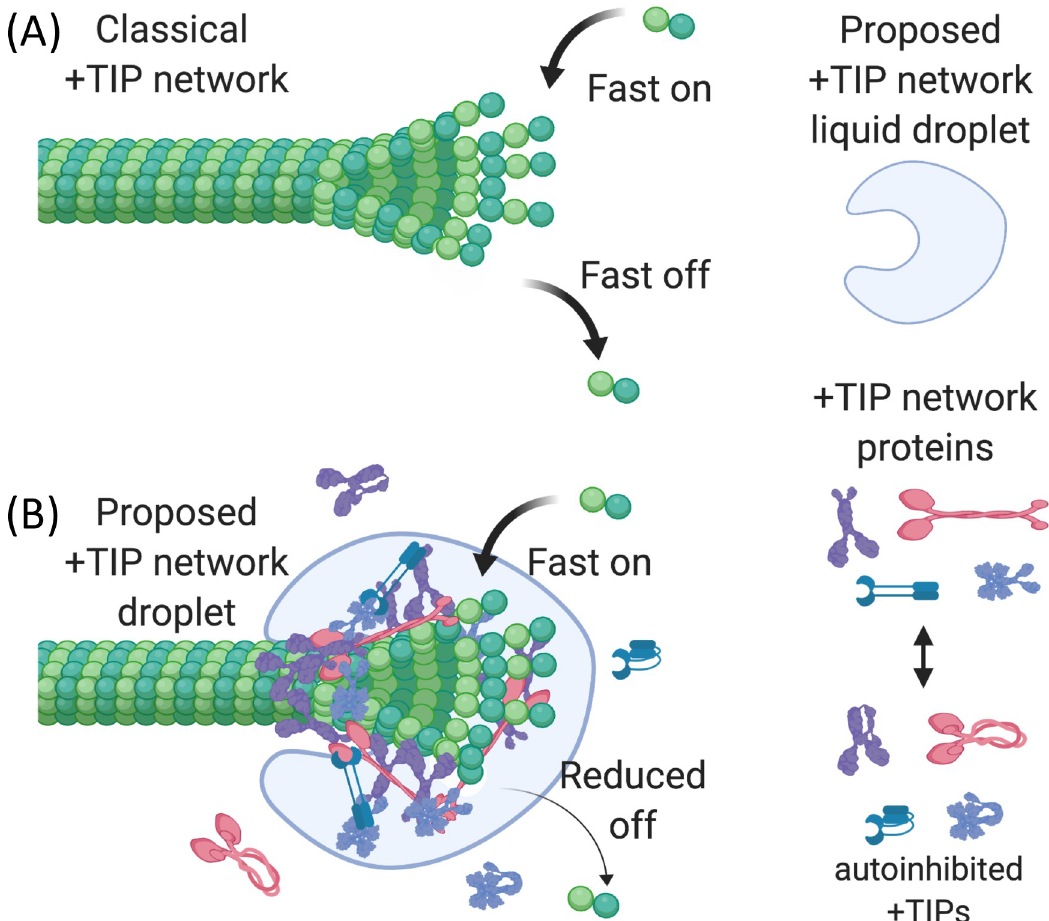
Fig 10. Proposed polymerization chaperone model. (A) In absence of the +TIP network, tubulin subunits arrive and leave quickly because most newly attached subunits are initially in the laterally unbonded regions of the tip protofilaments. The result is that MTs grow relatively slowly because most subunits detach before being incorporated into the laterally bound region of the MT. (B) In the presence of the proposed +TIP network liquid droplet, the web of interactions between the +TIPs creates a dynamic stocking-like structure that tracks the tip by diffusing on the potential energy gradient created by the preferential affinity of some tip components (most notably EB1) for tip-specific tubulin conformations. As the droplet moves, it exerts a force on the tip that promotes the zipping up of lateral bonds between protofilaments. This effect in turn increases the likelihood that newly arrived subunits are incorporated into the lattice and enables the MT to grow faster, as seen in vivo or with mixtures of +TIPs in vitro [4]. This figure was created with BioRender